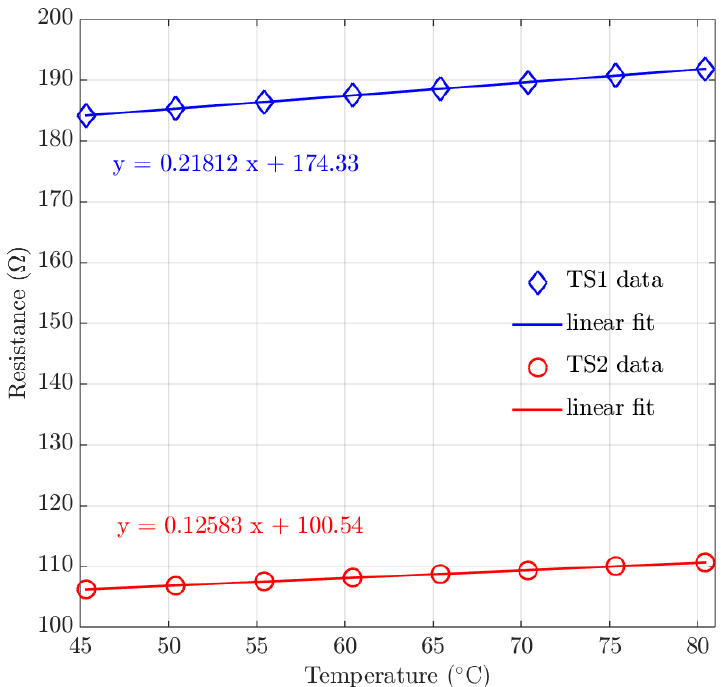
Figure 11. Plot of the measured resistance versus the oven temperature. The intercept with the y-axis is used to calculate the TCR of temperature